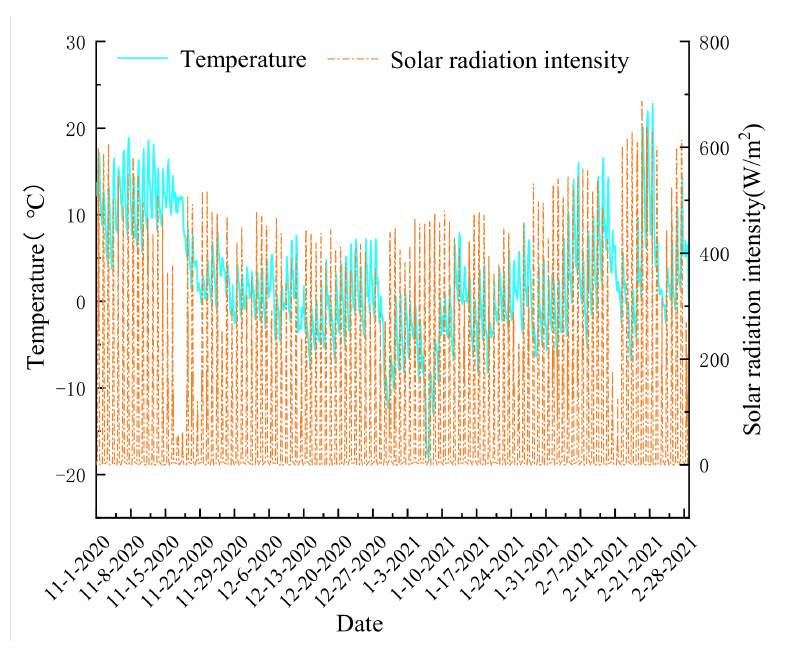
Figure 1. Outdoor weather conditions from 1 November 2020 to 28 February